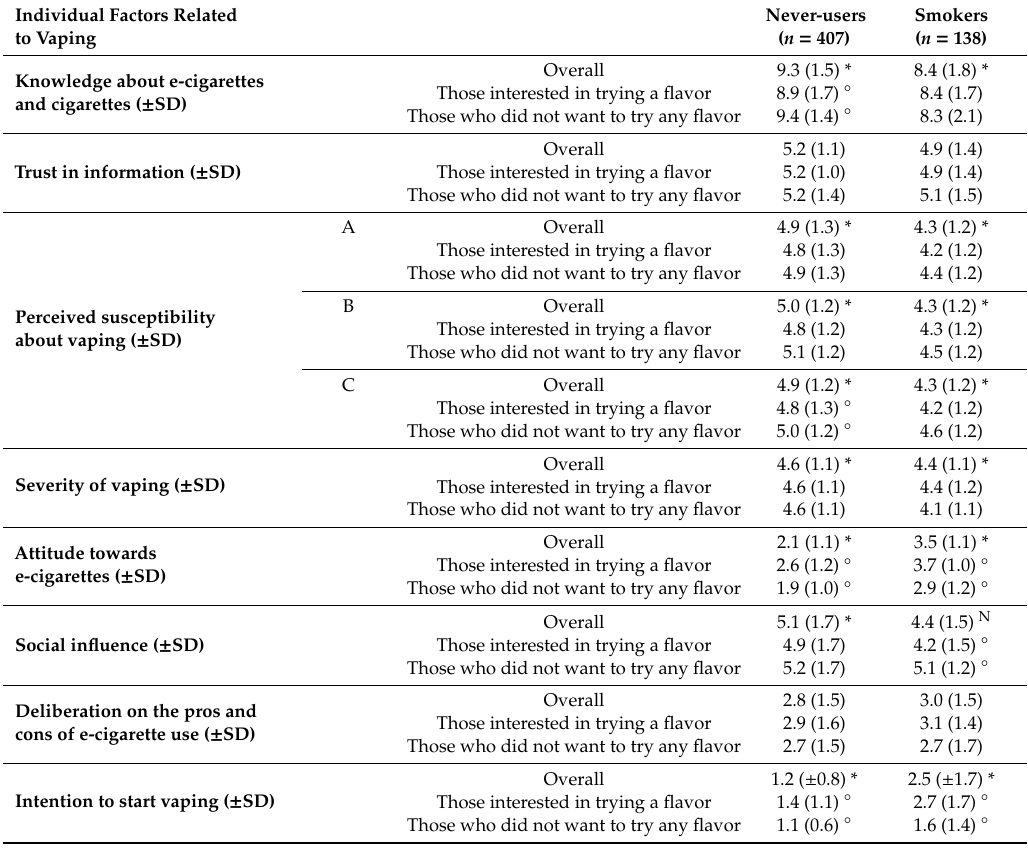
Table 2. Individual factors related to vaping. Data are presented for never-users and smokers. Individual Factors Related to